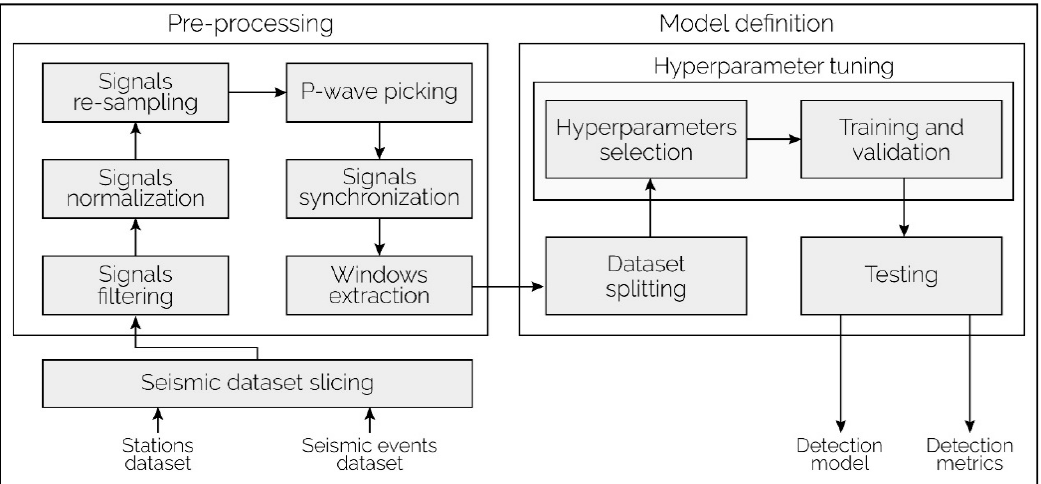
Figure 6. Classification process.